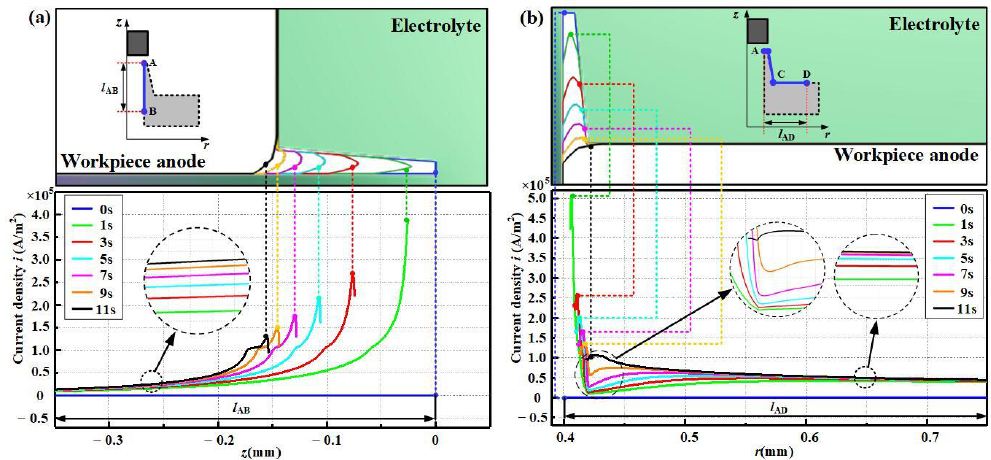
Figure 7. Current density distribution on the surface of the burr: ( a ) Current density distribution of l AB ; ( b ) Current density distribution of l AD .